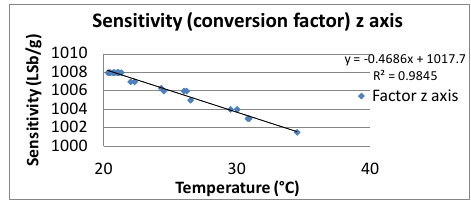
Figure 6. Sensitivity for z axis with temperature